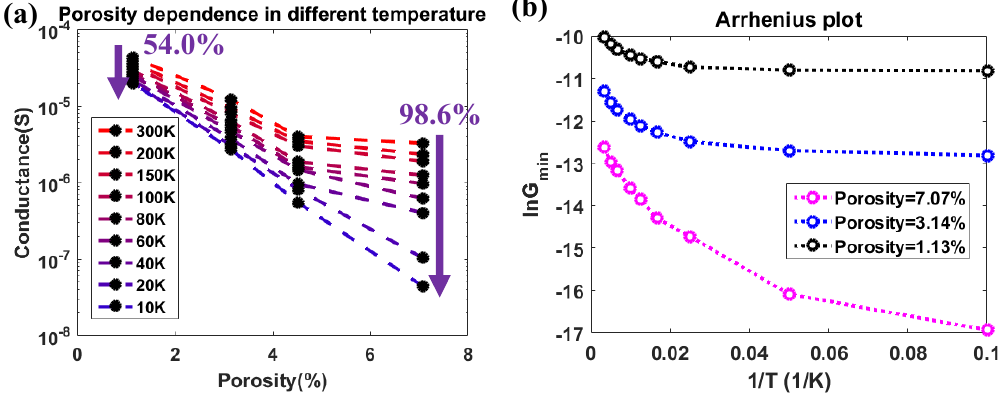
Figure 11. ( a ) Conductance variation of the GNM devices with different porosity from 300 K to 10 K. ( b ) Arrhenius plot example for the GNM devices with different porosities.